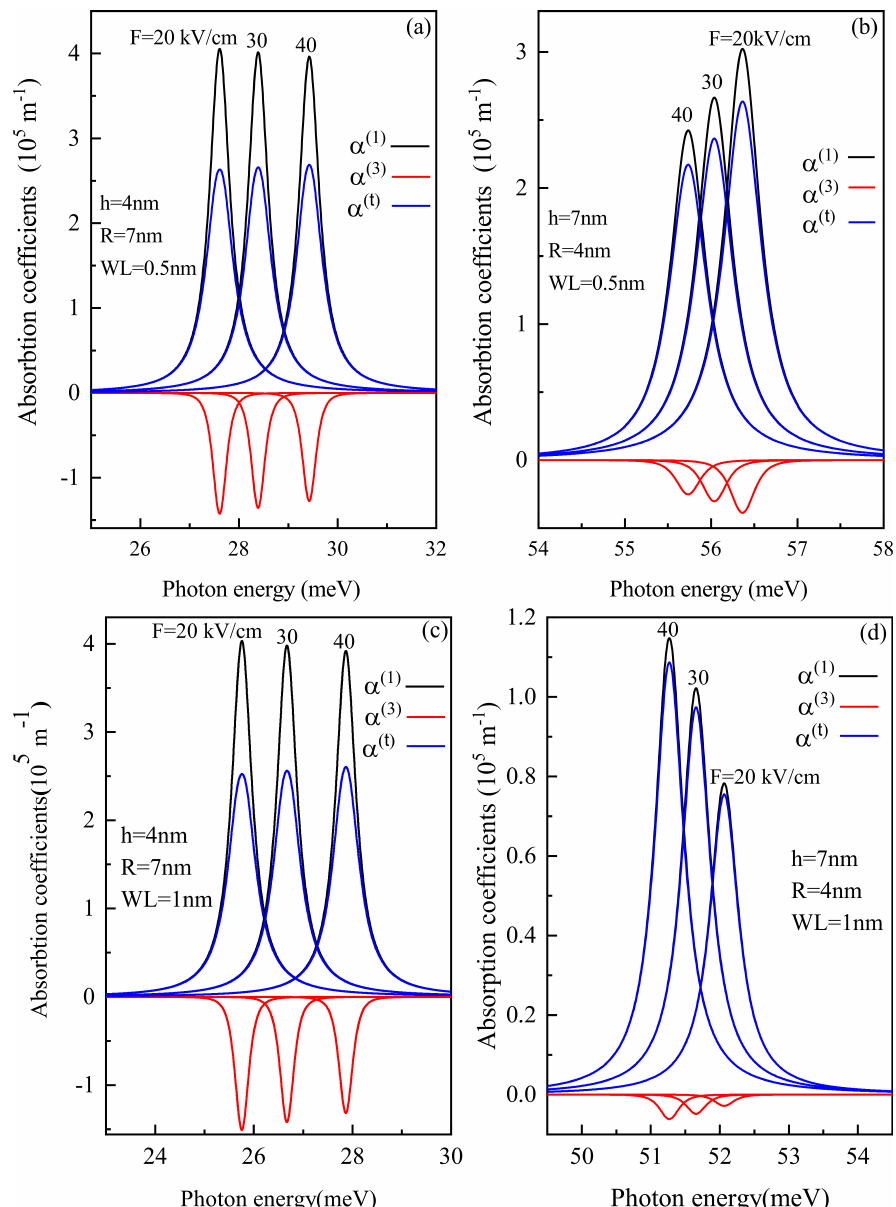
Figure 6. Linear, non-linear and total absorption coefficients as a function of the photon energy for ( a ) oblate height R = 4 nm with radius R = 7 nm at WL thickness 0.5 nm ( b ) prolate QD with R = 4 nm, h = 7 nm with WL thickness = 0.5 nm, ( c ) oblate QD with R = 4 nm, R = 7 nm with WL thickness = 1 nm, and ( d ) prolate QD with R = 4 nm, h = 7 nm with WL thickness = 1 nm for different values of the lateral electric field F = 20,30 and 40